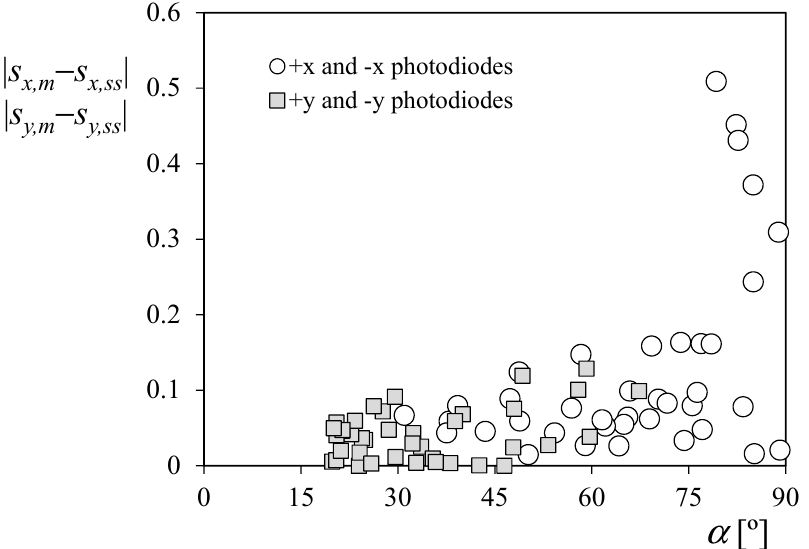
Figure 17. Differences between x -axis and y -axis coordinate values of the Sun direction based on the sun sensors system ( s x,ss , s y,ss , and s z,ss ) and on the magnetometers of the satellite’s ADCS ( s x,m , s y,m , and s z,m ) vs. the computed angle with regard to the corresponding illuminated photodiode using magnetometer data, α .